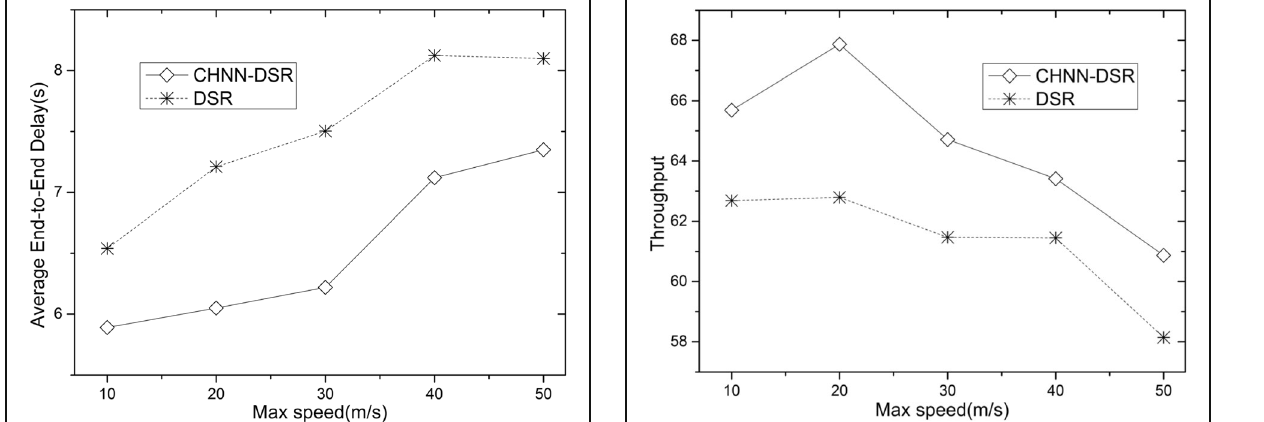
Fig. 3 Average end-to-end delay simulation results for DSR and CHNN-DSR. The simulation results of the average end-to-end delay for CHNN-DSR and DSR under the change of node